Question: Give a one-sentence summary of this figure.
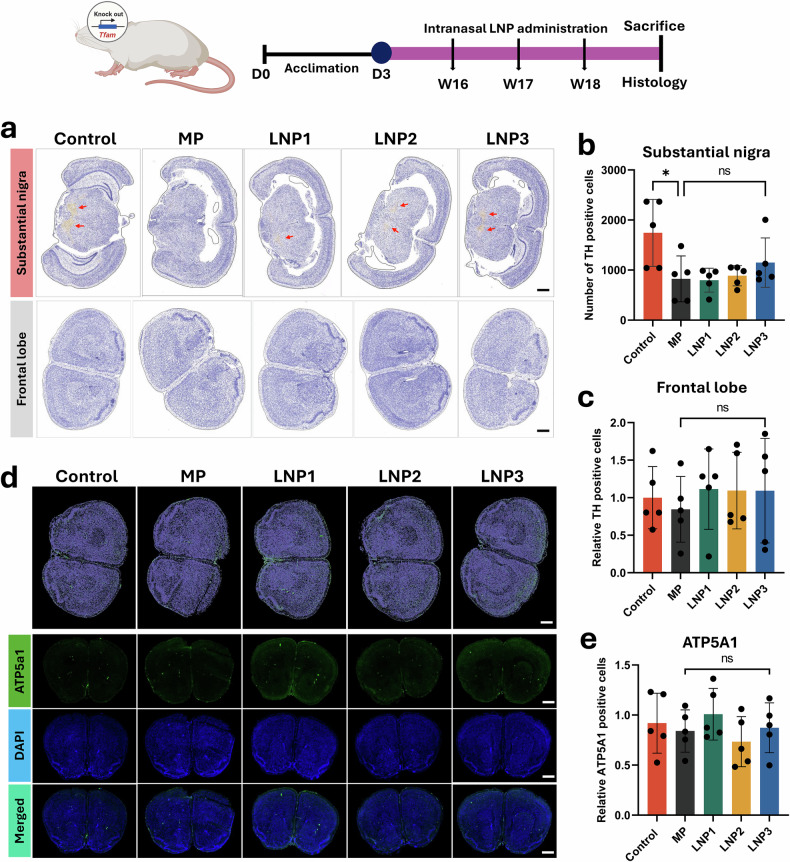
Answer: In vivo specific neuroprotective staining for dopaminergic neurons (TH) and mitochondrial integrity (ATP5A1). a – c Tyrosine hydroxylase (TH) immunostaining of the substantia nigra and frontal lobe. MP mice displayed a slight reduction in TH-positive cells (red arrows) in the SN, whereas the LNP2 and LNP3 groups exhibited partial modulation ( b ), but no changes were detected in the frontal lobe ( c ). d Immunofluorescence staining of ATP5A1 (green) with DAPI nuclear counterstain (blue) in control, MP, and LNP-treated mouse brains. e The number of ATP5A1-positive cells did not decrease in MP mice, but the number of LNP1-positive cells was slightly restored. (Scale bar is 1000 μm.) The results are reported as the mean ± SD ( n = 5; ns > 0.05; * p < 0.05). Statistical analysis was performed using one-way ANOVA followed by Dunnett’s multiple comparisons test